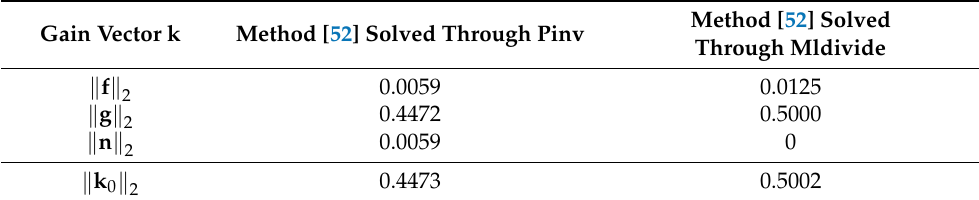
Table 7. Control gain 2-norms in the numerical example of the assignment of zeros through unit-rank active control with integral action.